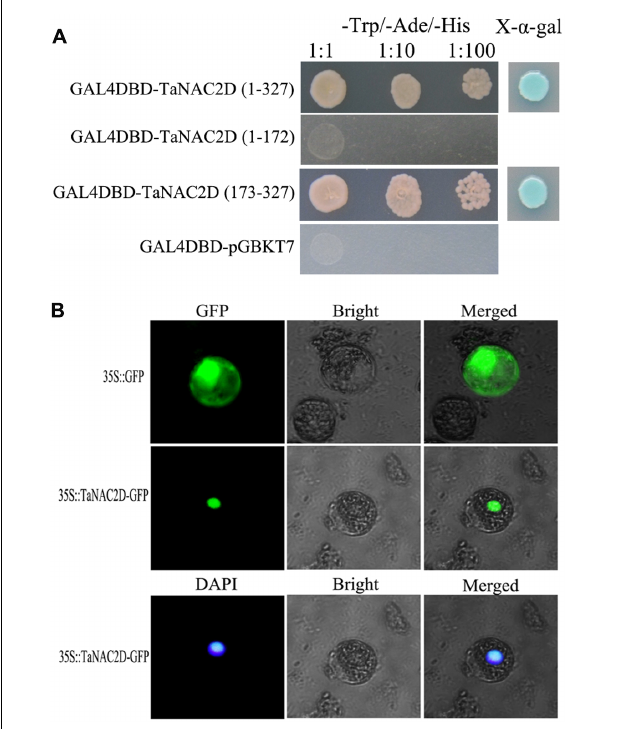
FIGURE 1 | Transactivation activity and subcellular localization of TaNAC2D. (A) Transactivation activity of TaNAC2D in yeast strain AH109. Full-length and truncated versions of TaNAC2D were fused into pGBKT7 vector and the transformants were screened on the SD/-Trp-Ade-His plates with or without X- α -gal. (B) Subcellular localization of TaNAC2D. The fusion protein pMD18-35S-TaNAC2D-GFP and pMD18-35S-GFP (control) were transiently expressed in wheat mesophyll protoplasts and observed with fluorescence